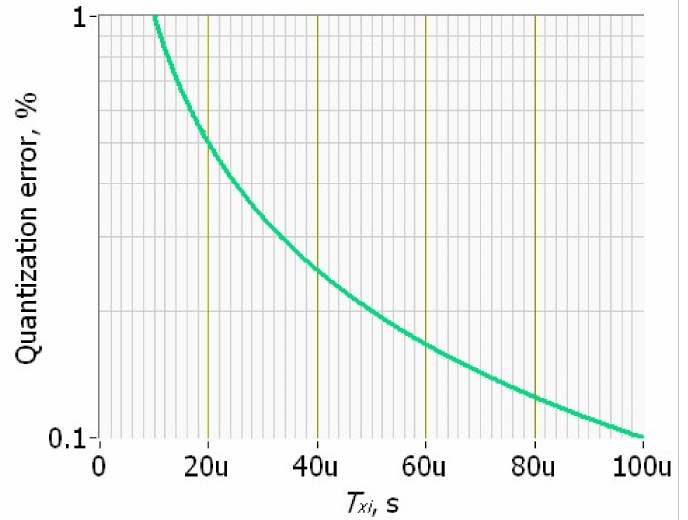
Figure 3. An example of the quantization error curve for the frequency f 0 = 10 MHz and the T xi periods values of the quantized waveform varying from 10 µ s to 100 µ